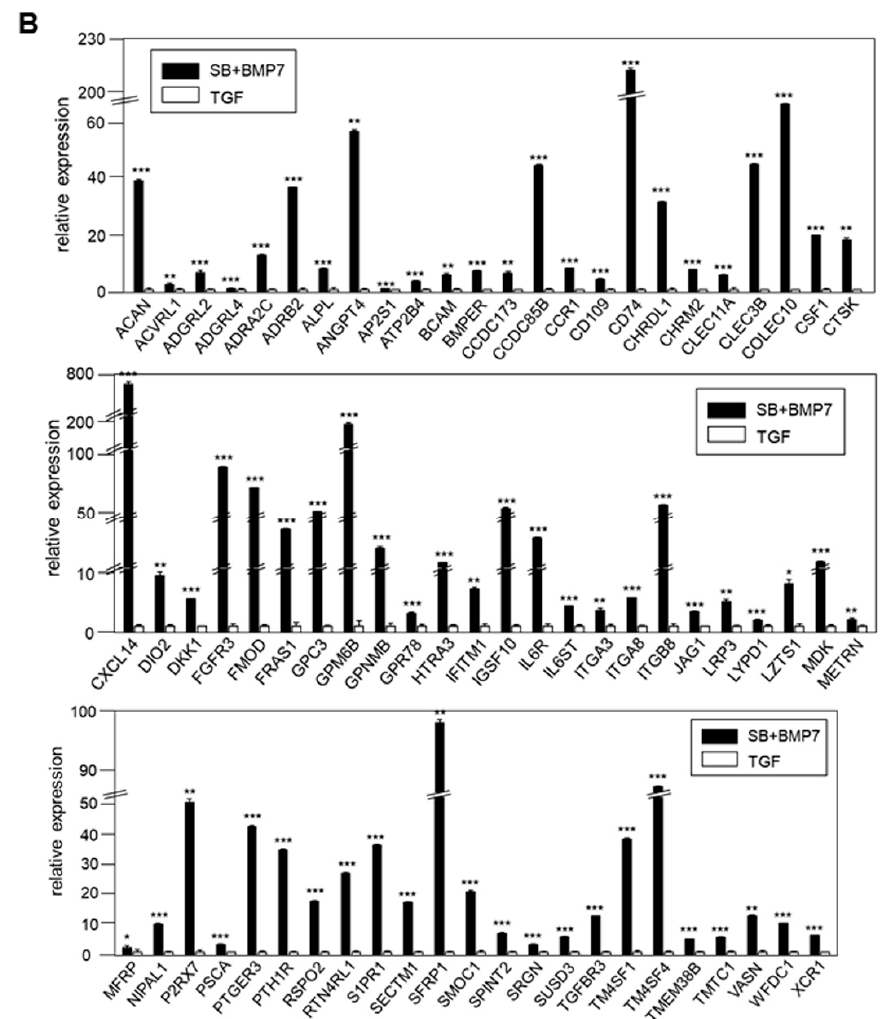
Figure 6. Validation of the expression of DEGs by qRT-PCR. ( A ) In total, 86 of 142 DEGs upregulated by TGF- β 1 treatment were confirmed by qRT-PCR. ( B ) In total, 69 of 114 DEGs upregulated by SB431542 and BMP7 treatment were confirmed by qRT-PCR. Statistical significance of * p < 0.1, ** p < 0.05, or *** p < 0.01 was determined by Student t -test. ns: not significant. The expression of 69 upregulated genes in the SB+BMP7-treated cells was also consis- tent with the RNA-Seq results (Figure